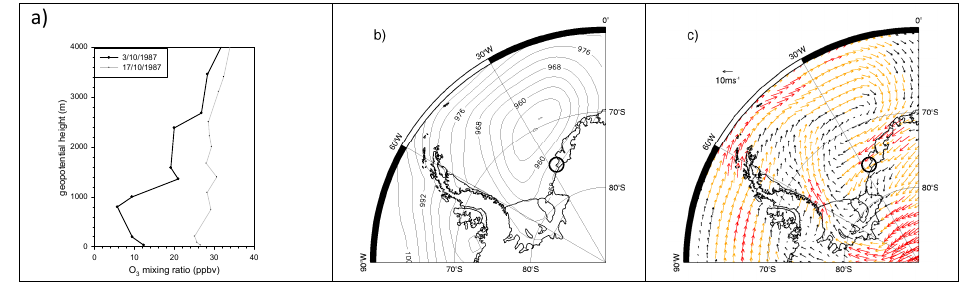
Fig. 17. (a) Ozonesonde measurements on 3 October 1987 compared with an un-depleted profile for the middle of the same month; (b) mean sea level pressure on 3 October 1987 (06:00); (c) 10-m wind vectors on 3 October 1987 (06:00) – wind speeds identified as: black = < 8ms − 1 ; orange = 8 to 12ms − 1 ; red = > 12ms − 1 . Halley is marked by the black circle on the